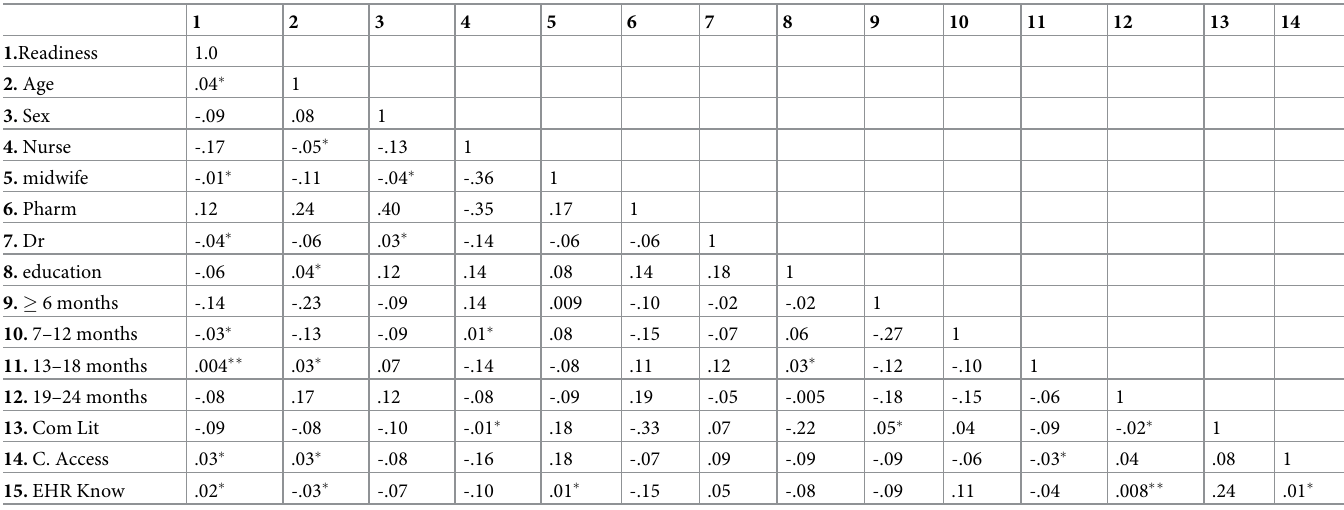
Table 3. Correlation between the independent variables and health provider readiness.